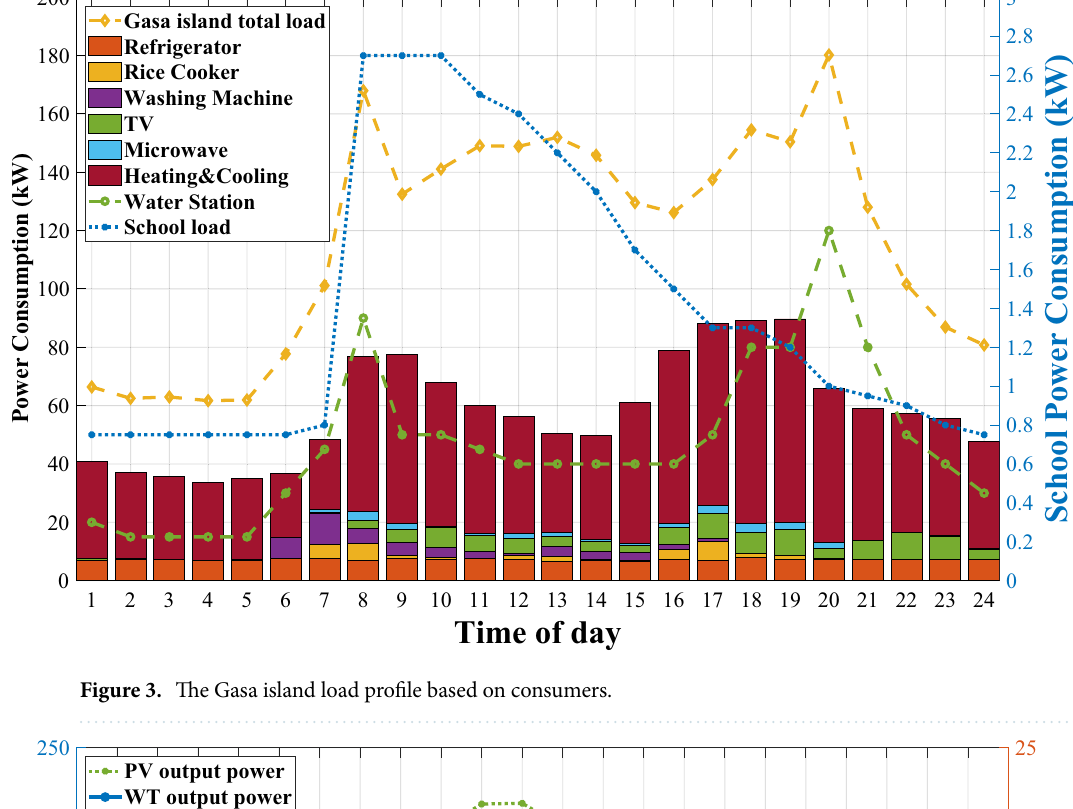
Figure 3. The Gasa island load profile based on consumers.